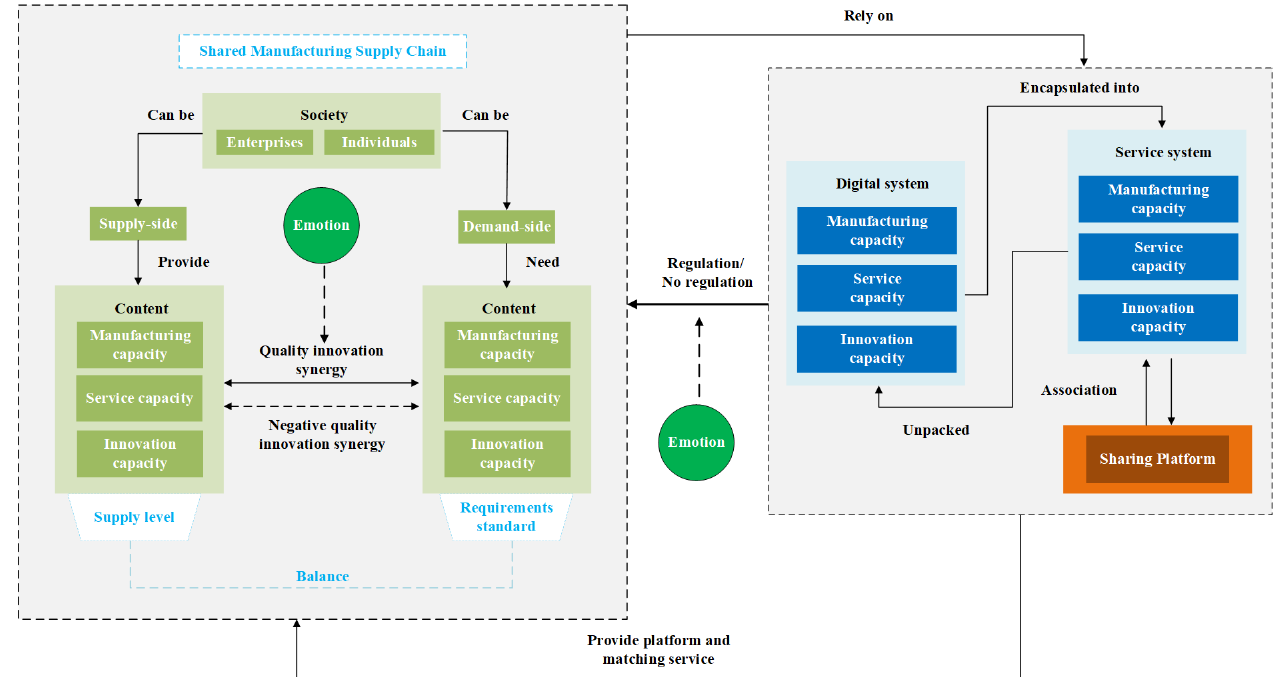
Figure 2. Conceptual diagram of the game model.